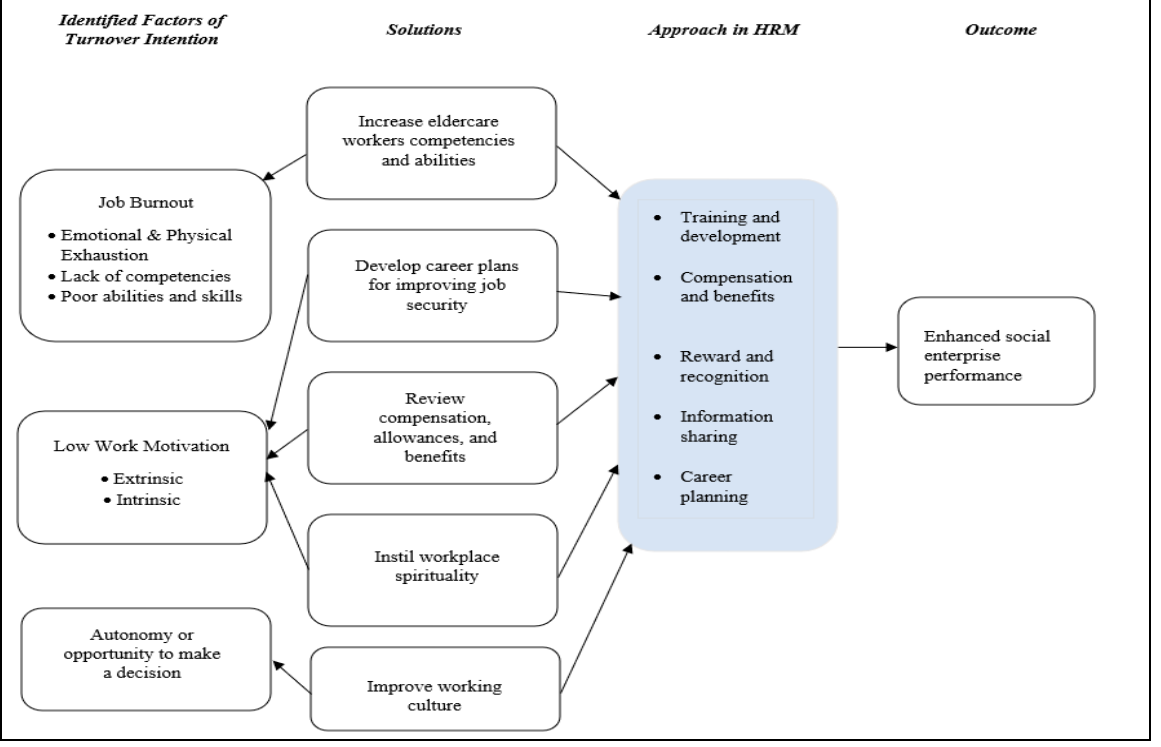
Figure 3. Study Framework.